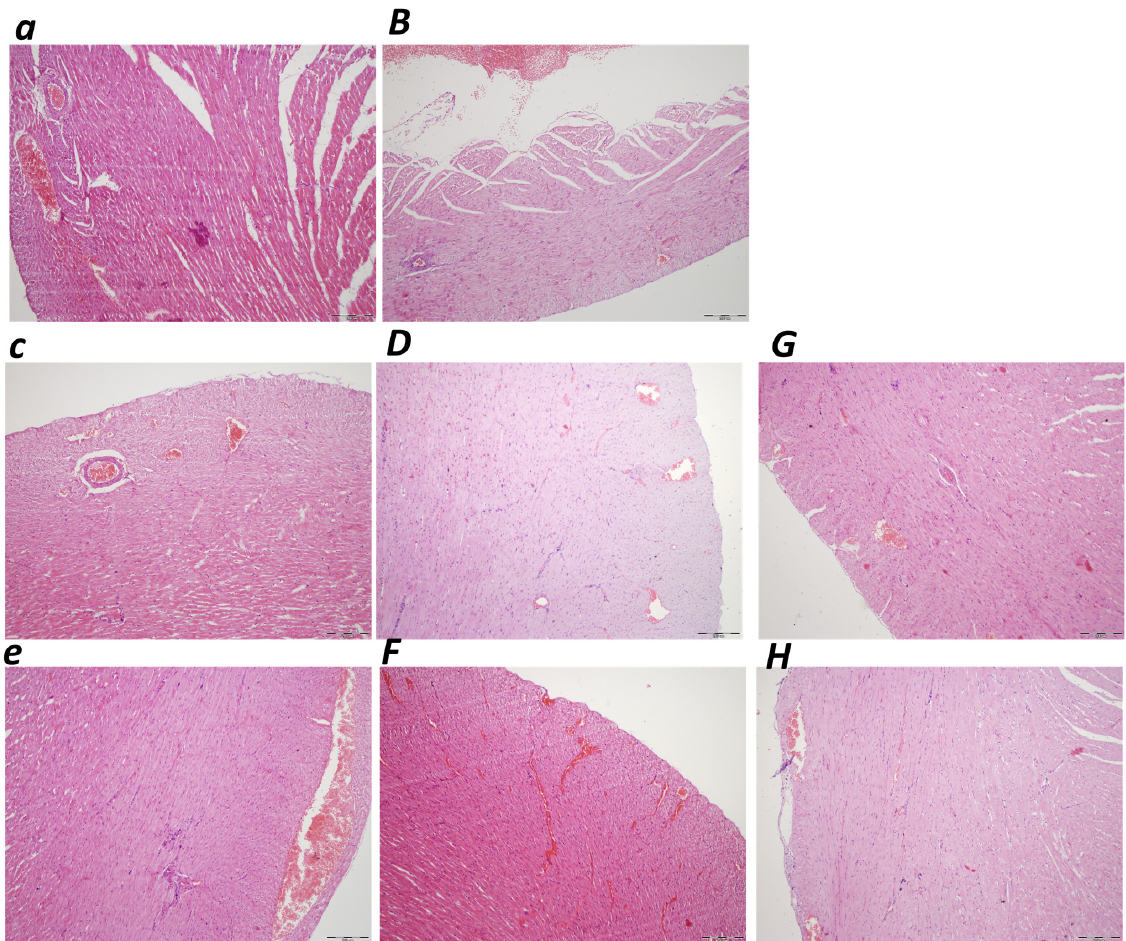
Figure 7. Heart congestion illustrative microscopic presentation (HE staining; magnification 100×;